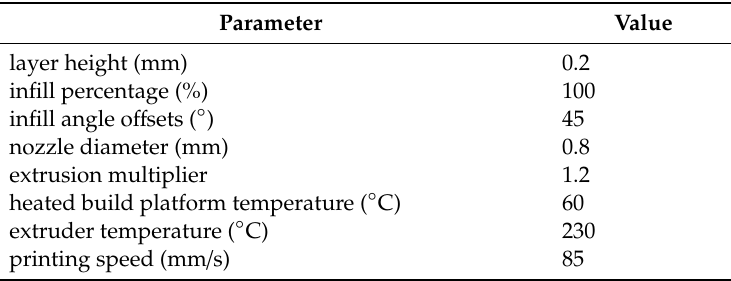
Table 1. Printing conditions for